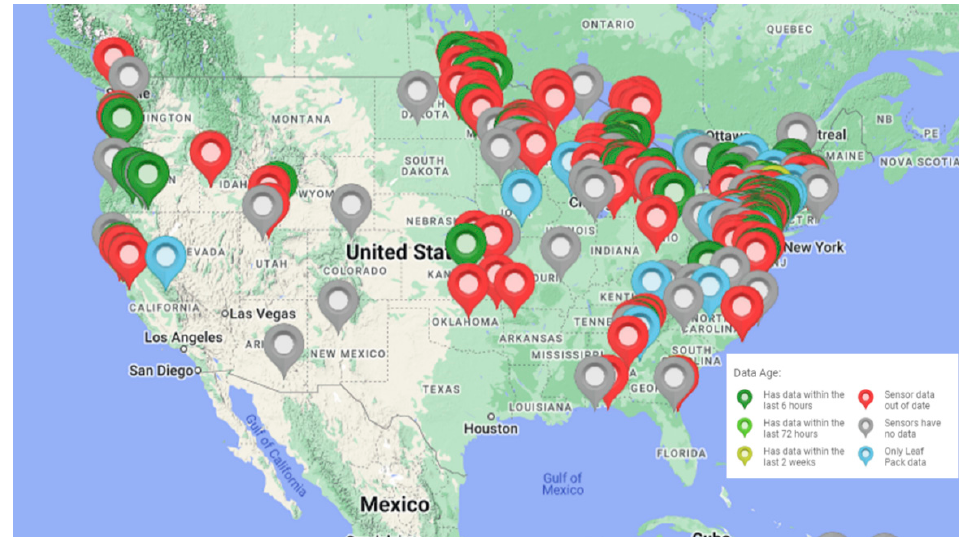
Figure 4. Geo-spatial locations of stream monitoring stations in the United States from EnviroDIY data sharing portal.